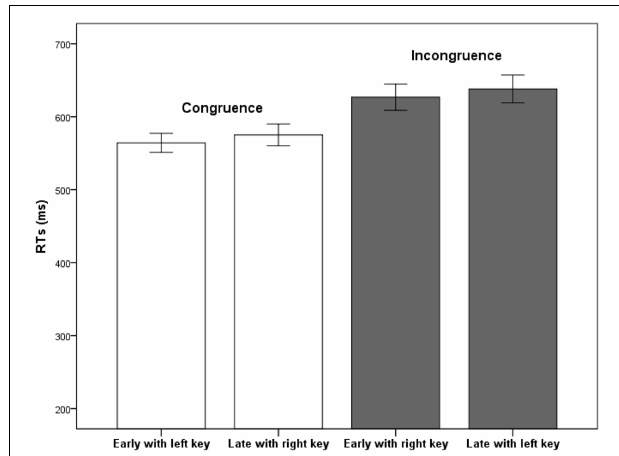
FIGURE 1 | Mean RTs in Experiment 1 as a function of response congruence and temporal position. Error bars represent standard errors of the